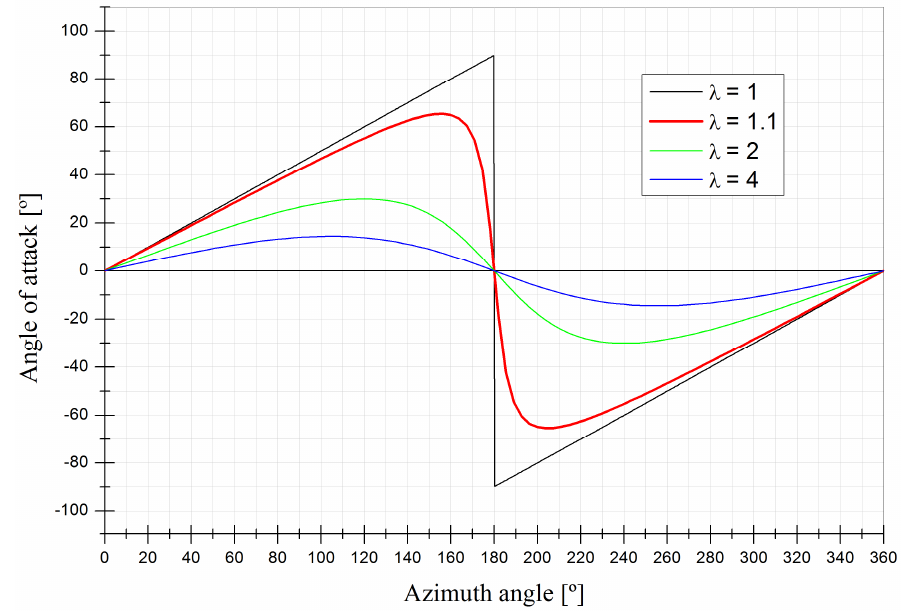
Figure 3. Angle of attack variation in a blade revolution for different tip speed ratios.